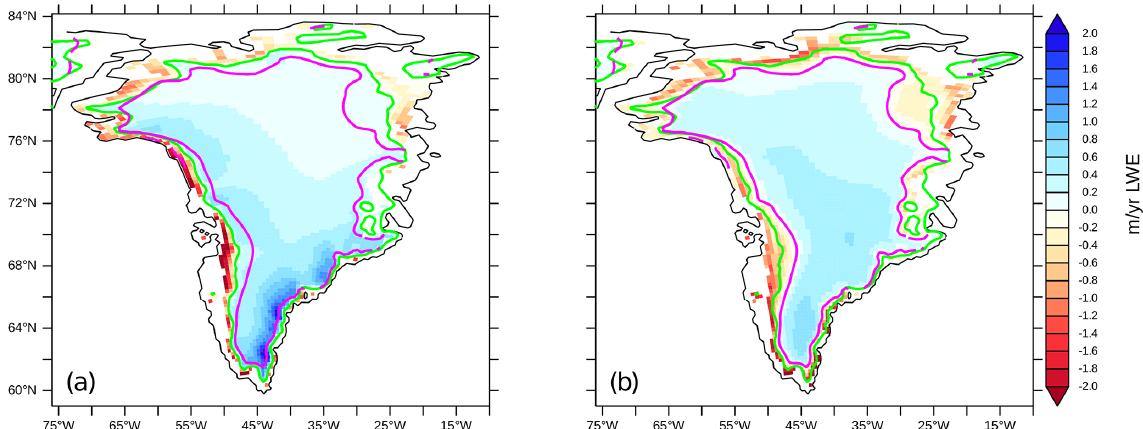
Figure 6. Annual average surface mass balance (myr − 1 LWE) for the surface of Greenland in (a) MAR (1980–1999, minimum − 3.4; maximum 2.1) (Fettweis et al., 2013) and (b) FAMOUS-ice (minimum − 4.3; maximum 0.83). To visualise the distribution on sub-grid- scale tiles, FAMOUS-ice results have been trilinearly mapped to the same topography as used in MAR. The green contour shows the MAR equilibrium line, and the pink is the FAMOUS-ice equilibrium line.